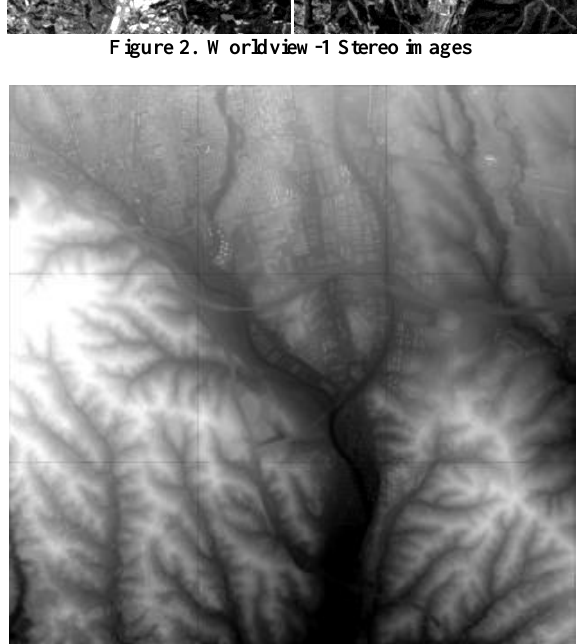
Figure 3. Reference DEM derived from LIDAR data of